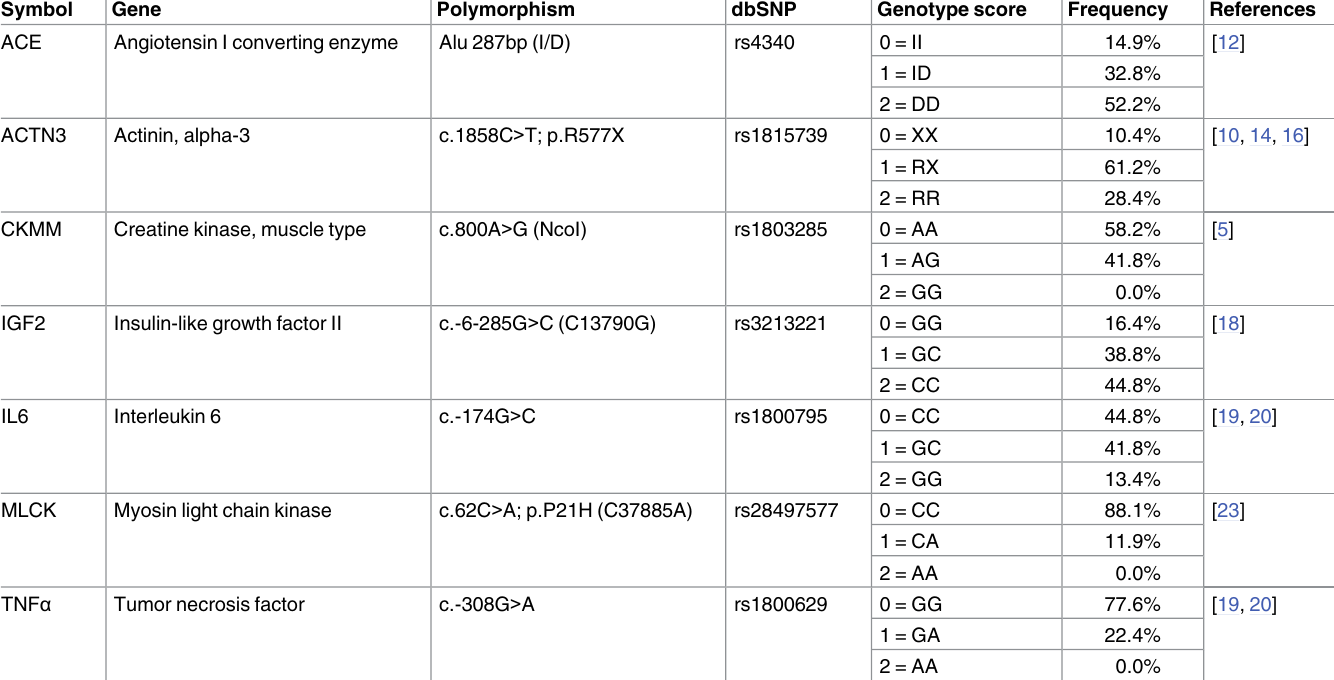
Table 2. Studied polymorphisms in amateur marathon runners. Genotype scores have been basedon previousresearch as follows: 2 = optimalgeno- type; 1 = standardgenotype; 0 = suboptimal genotypefor muscle